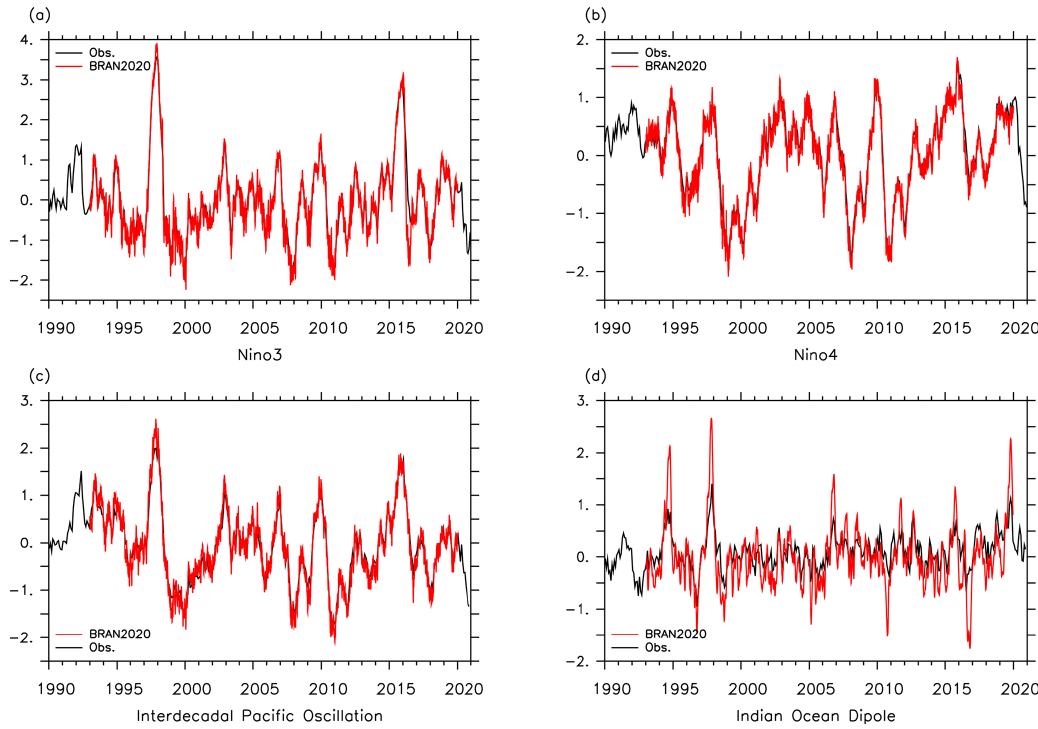
Figure 10. Major climate SST indices: (a) Niño 3 (5 ◦ S–5 ◦ N, 210–270 ◦ E), (b) Niño 4 (5 ◦ S–5 ◦ N, 160–210 ◦ E), (c) Interdecadal Pacific Oscillation (Henley et al., 2015) and (d) the Indian Ocean Dipole (10 ◦ S–10 ◦ N, 50–70 ◦ E; 10 ◦ S–0 ◦ N, 90–110 ◦ E). Table 5. Transport, in sverdrups (10 6 m 3 /s 1 ) of various boundary current systems in the Australian region with results from Schiller et al. (2008b). Positive (negative) transports are northward or eastward (southward or westward). Uncertainties are 1 standard deviation of daily transport values. Transect positions are indicated in Fig. 12. Position Schiller et